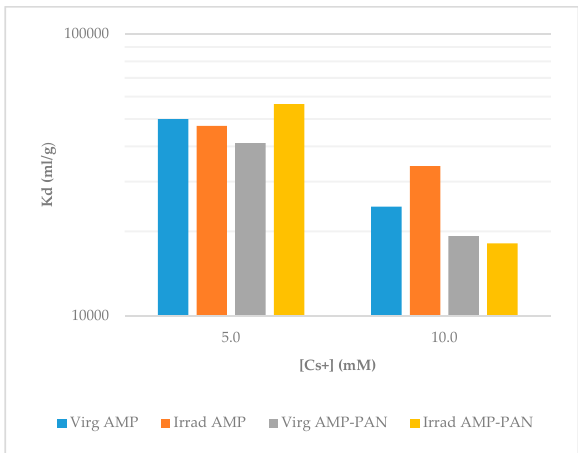
Figure 4. Variation of 24 h exposure Cs + K d values in AMP and AMP-PAN at 5 and 10 mM Cs in 3 M HNO 3 . NB: Y -axis is logarithmic.